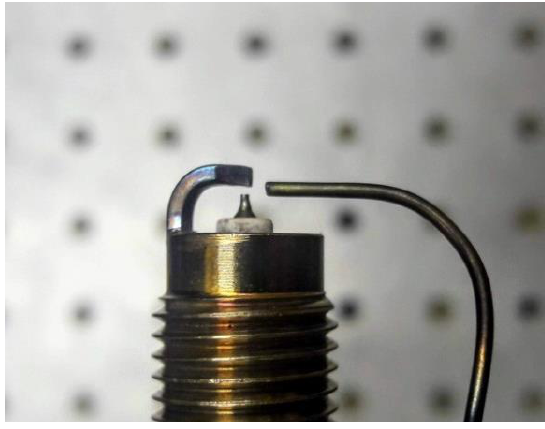
Fig. 2. Measurement of the ionization sensor operating temperature